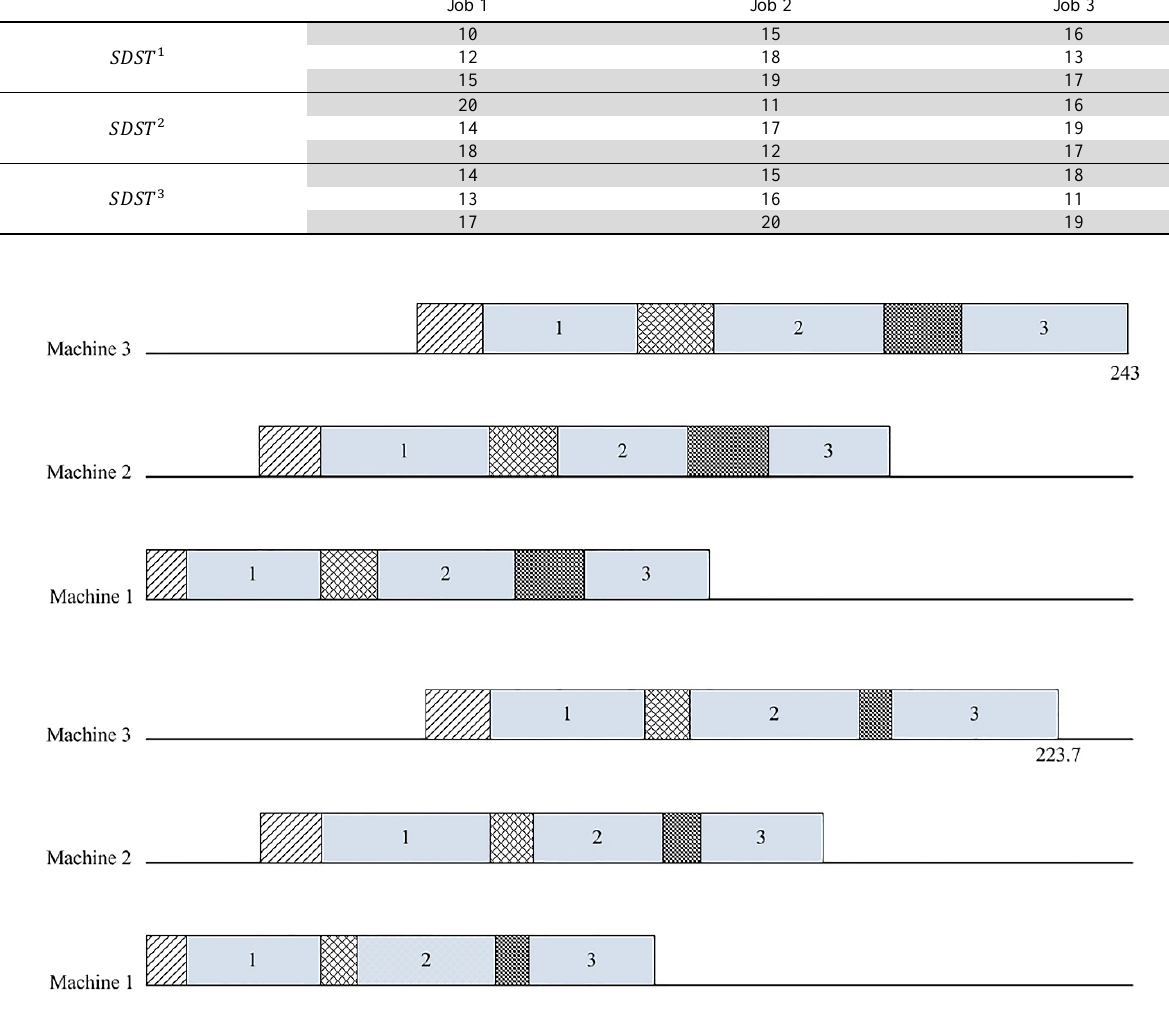
Fig. 1. Comparison of solution by